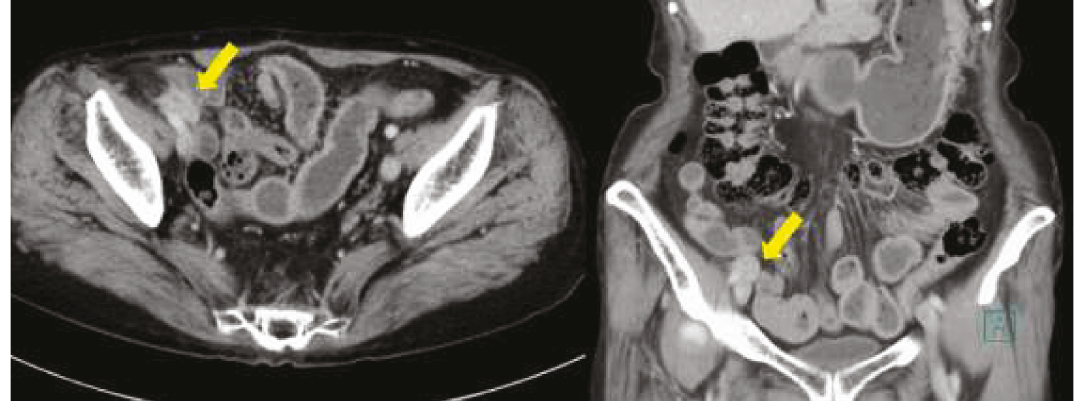
Figure 2: Contrast-enhanced CT scan showing an irregular tumor around the right external iliac vessels and the small intestine, contiguous to the small intestine